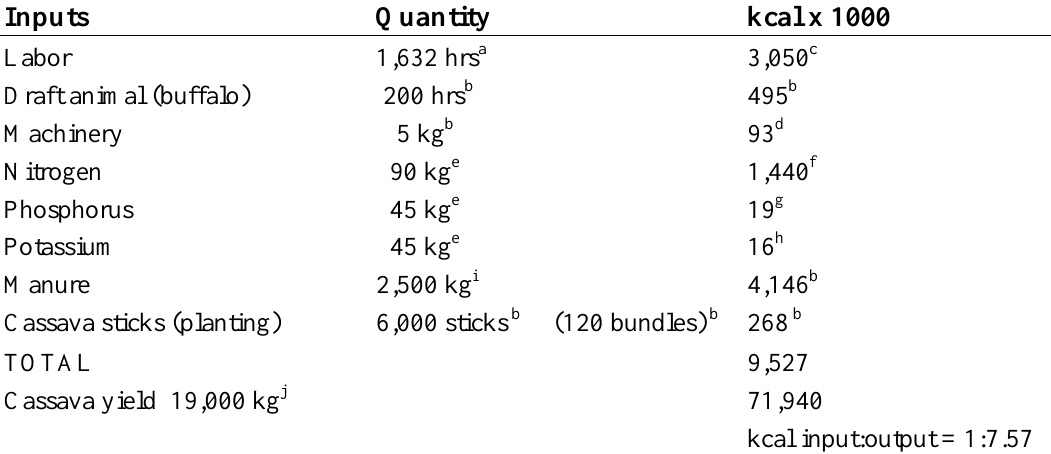
Table 12. Energy inputs for cassava production per hectare in Nigeria.